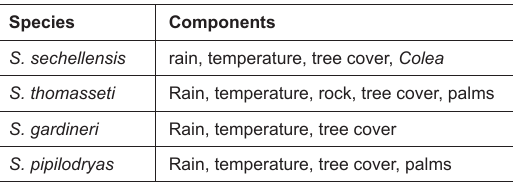
Table 3. Components of the most accurate distribution models for